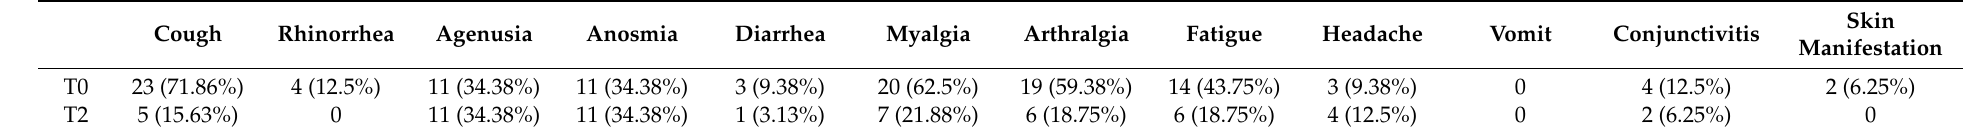
Table 4. Symptoms in standard of care (SOC)-treated COVID-19 group at T0 (baseline) and at T2 (end of the